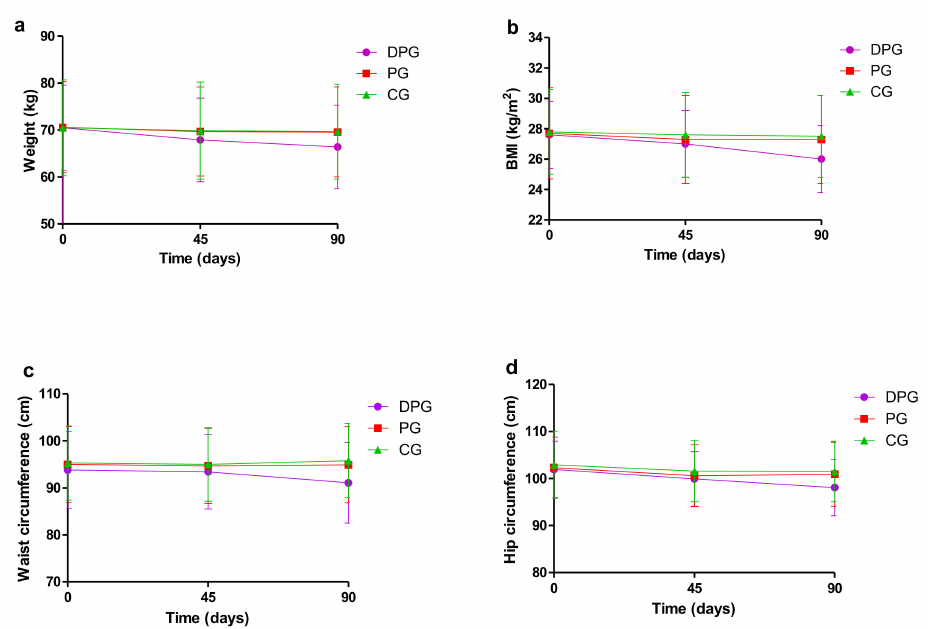
Figure 4. Weight outcomes at three different times. Measures of weight outcomes included ( a ) body weight, ( b ) body mass index (BMI), ( c ) waist circumference (WC) and ( d ) hip circumference (HC).